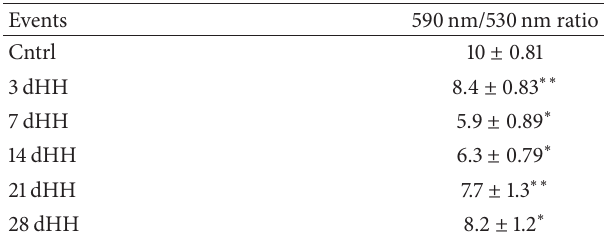
Table 2: Spectrophotometric investigation of mitochondrial mem- brane potential ( Δ𝜓 𝑚 ).